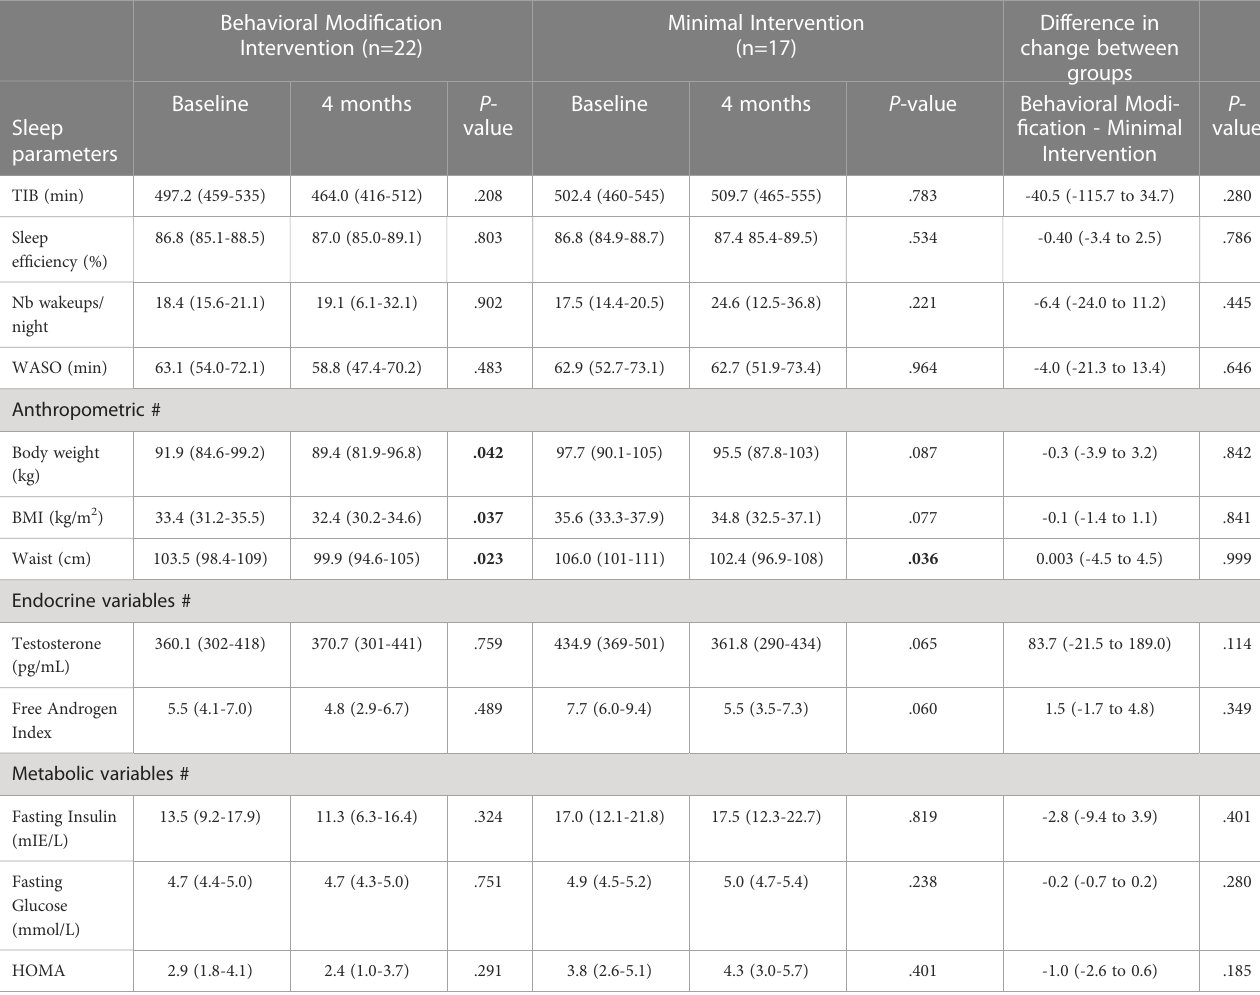
TABLE 2 Sleep, anthropometric, endocrine and metabolic parameters at baseline and after 4 months of intervention for the women with